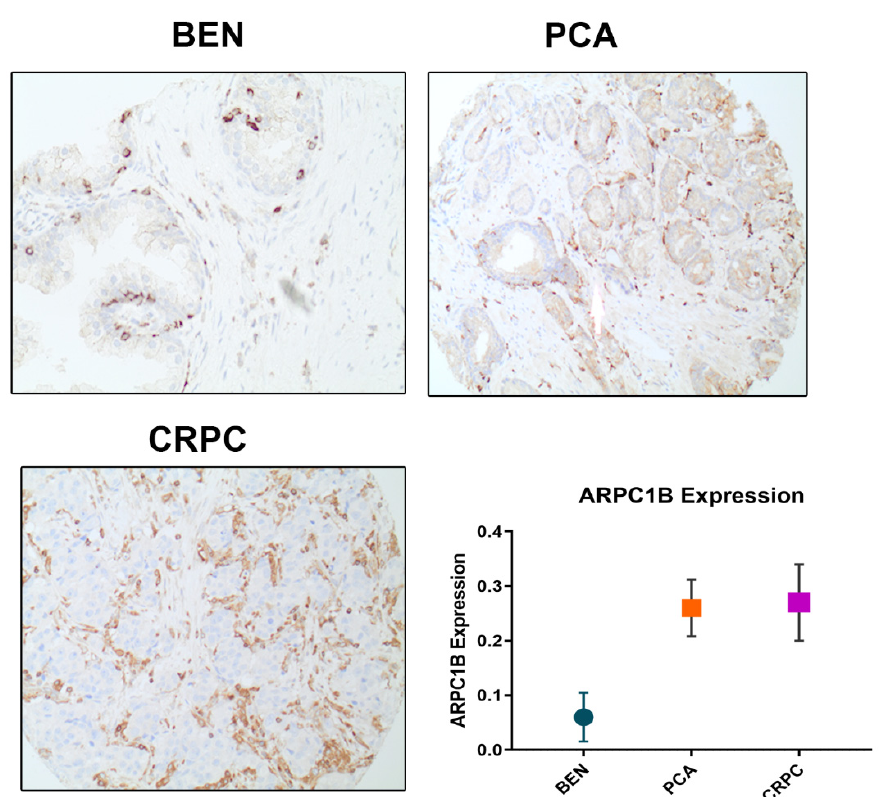
Figure 1. ARPC1B expression in clinical prostate cancer cases. Immunohistochemistry staining (IHC) shows ARPC1B expression in Benign (BEN, 10 × ), localized prostate cancer (PCA, 4 × ), and castration resistance prostate cancer (CRPC, 10 × ) in human tissue samples. The mean expression of ARPC1B in BEN, PCA, and CRPC in human tissue samples. ARPC1B protein expression levels were scored through IHC. Each sample was scored semi quantitatively using four-tiered system (negative—0; weak—1; moderate—2; strong—3). The error bars indicate the Standard error of the mean. Student t-test was performed, p value < 0.05 was considered significant between prostate cancer CRPC, and localized PCa was compared with benign. p < 0.0144, p < 0.0123.